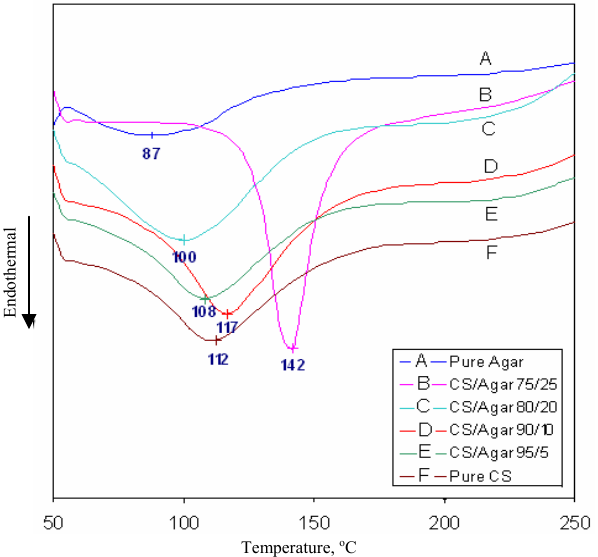
Figure 7. DSC curves of various chitosan/agar blended films